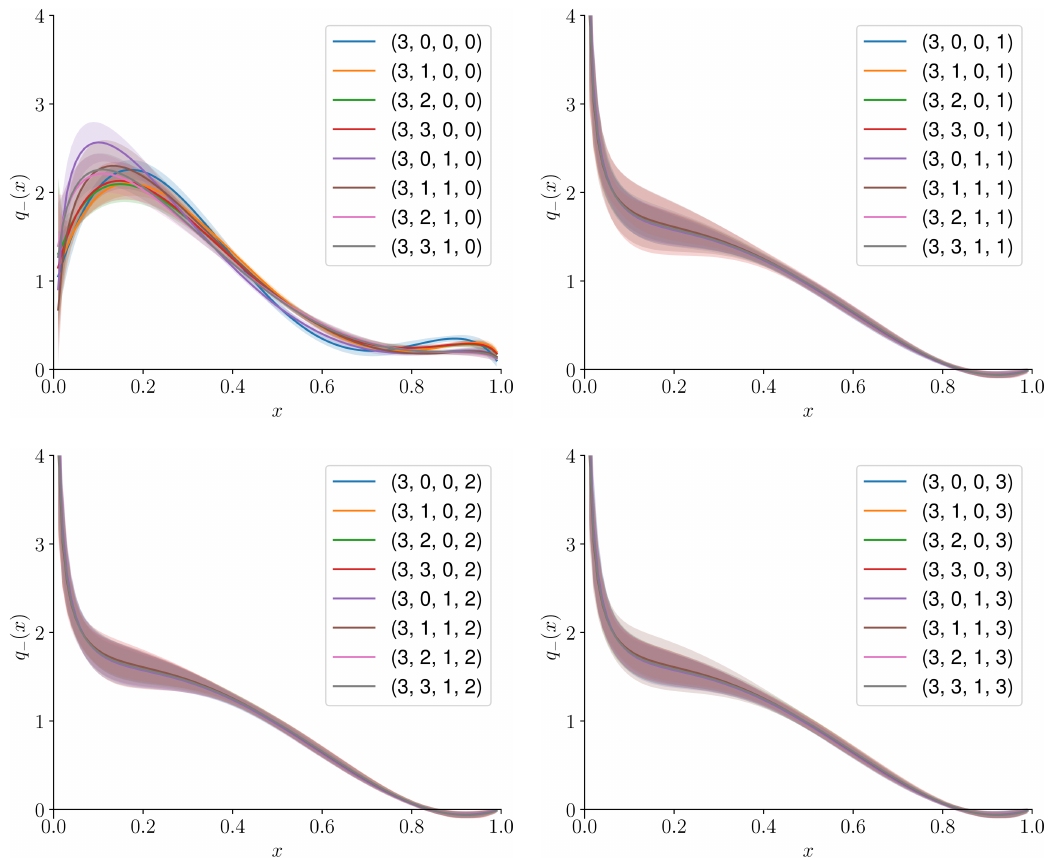
Figure 15 . The PDF results from fitting the real component to the models. The numbers in the legend correspond to ( N ± , N